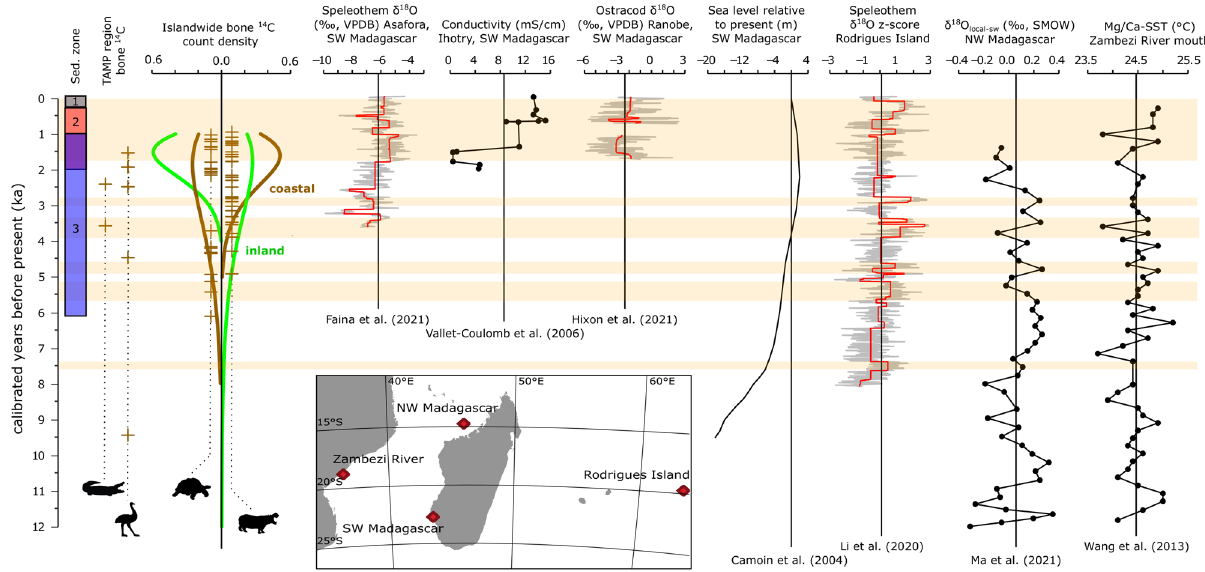
Figure 3. Occurrence of Tampolove fauna on a scale of absolute time relative to local sedimentary zones (Fig. S9), approximate changes in relative sea level on Madagascar, and regional paleoclimate records from points marked in the inset map. Islandwide bone collagen 14 C date count densities are given for giant tortoises and hippos and are separated according to whether data come from coastal lowlands or inland sites (Fig. 1). Bayesian change point analysis (BCPA) in the Asafora, Ranobe, and Rodrigues records (red lines) identify intervals that can be approximated reasonably well by a single mean, and the overall means of these records are given by black vertical lines. Intervals with above average values highlighted by BCPA in at least one record (indicative of relatively arid conditions) are highlighted with brown horizontal bars for reference. Note that the plot includes two pygmy hippos and two giant tortoises that are likely duplicate